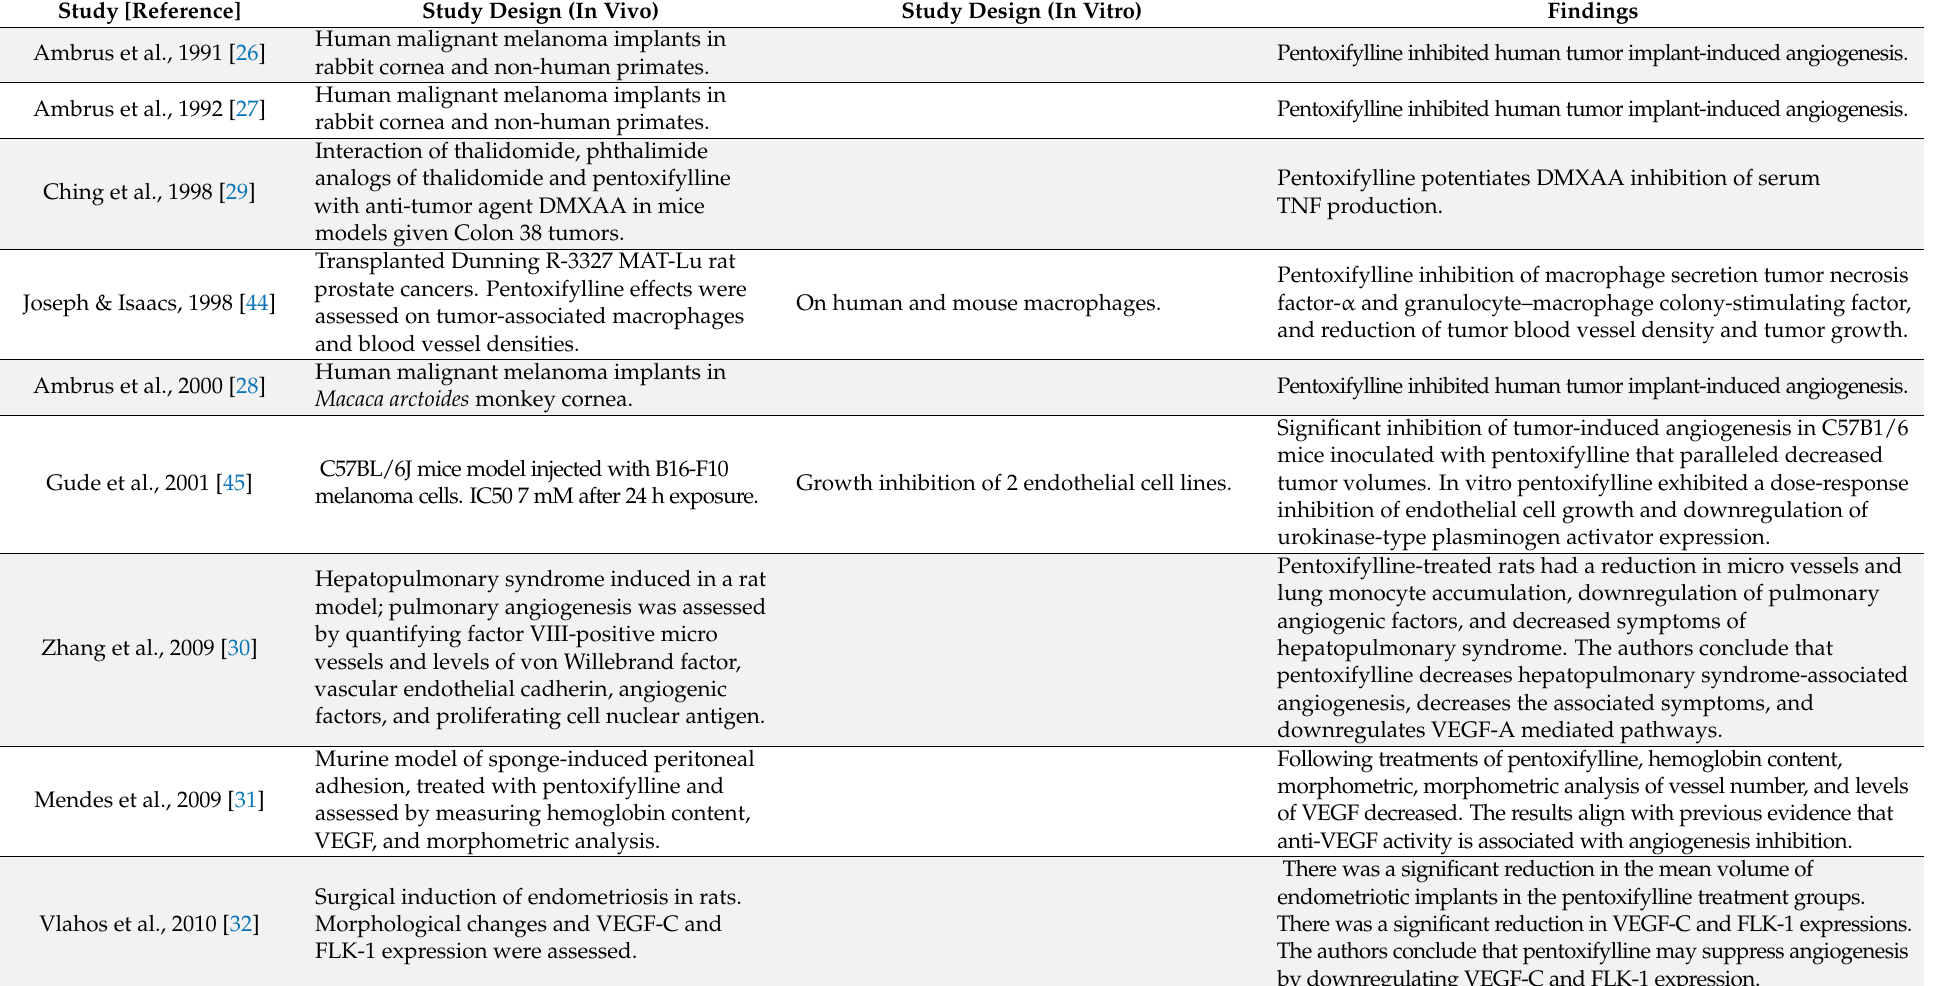
Table 1. Summary of the included